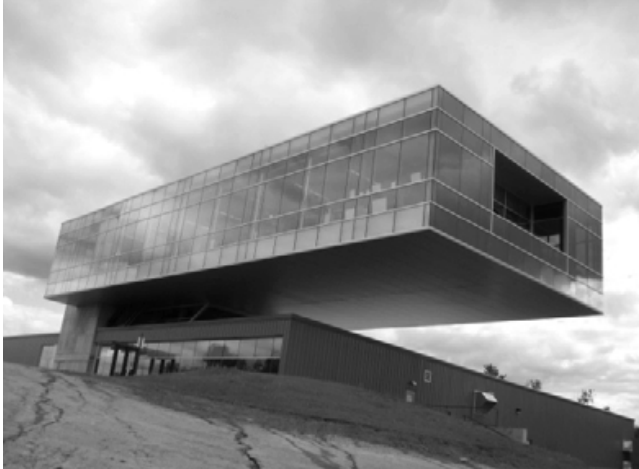
Fig. 1. The lamar construction headquarters, Hudsonville, Michigan.